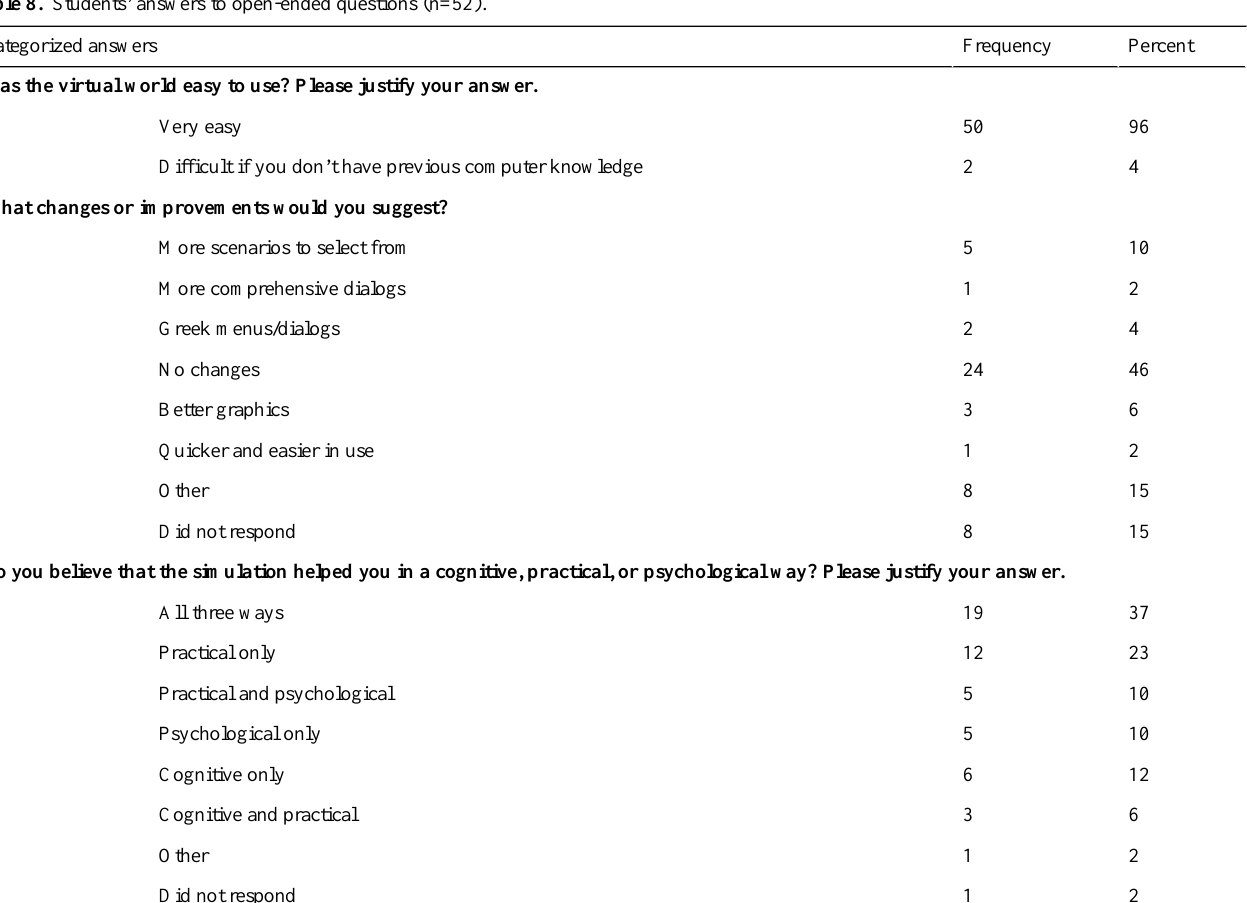
Table 8. Students’answers to open-ended questions